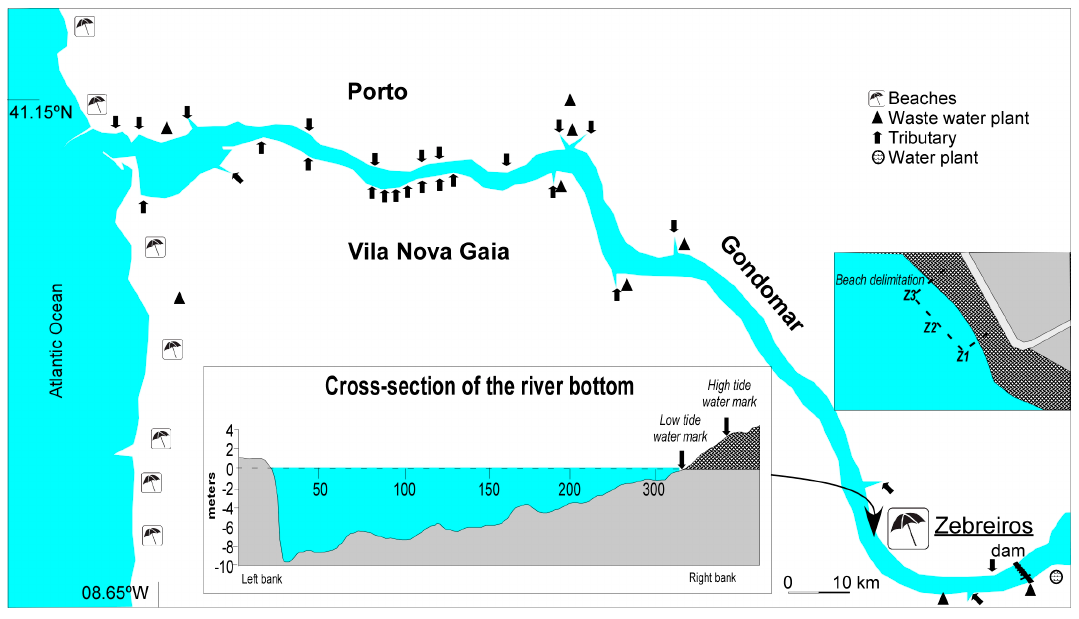
Figure 1. Zebreiros beach within the Douro estuary (NW Portugal). Inserts—cross section of the river bottom relative to the beach; and sampling location with beach delimitation.